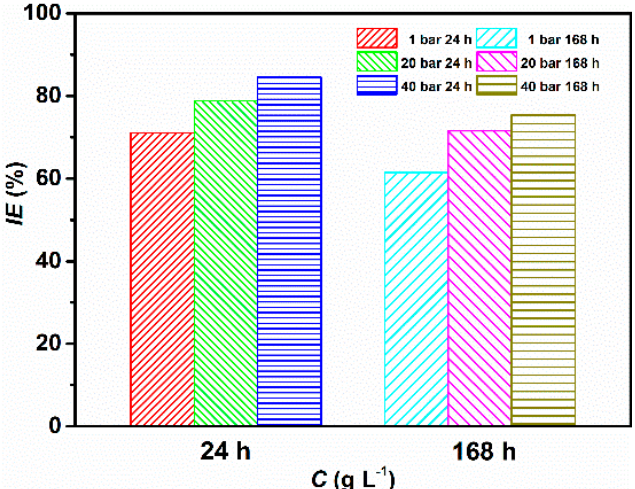
Figure 5. Corrosion inhibitor efficiency obtained at different CO 2 partial pressures after 24 and 168 h of immersion at 25 °C.